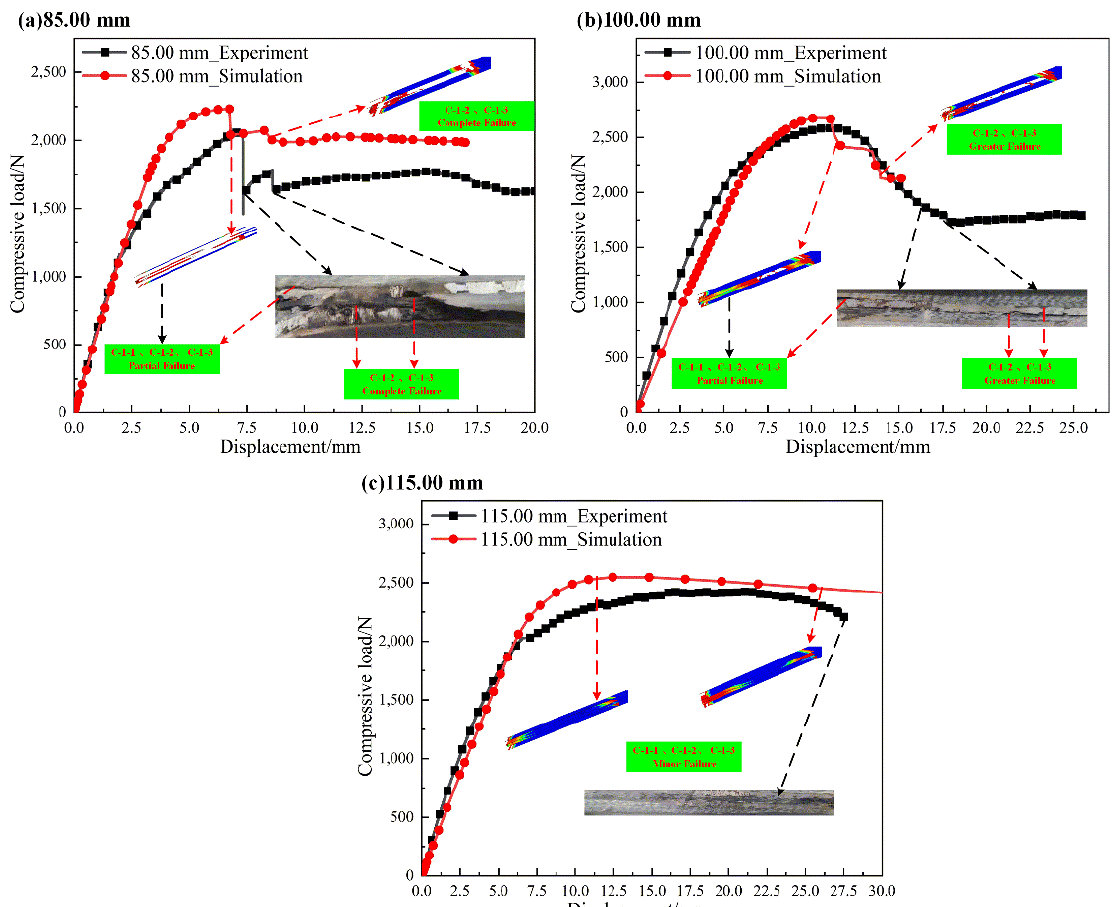
Figure 15. Load–displacement curves for L-joints with different bonding lengths: ( a ) 85.00 mm, ( b ) 100.00 mm and ( c ) 115.00 mm.